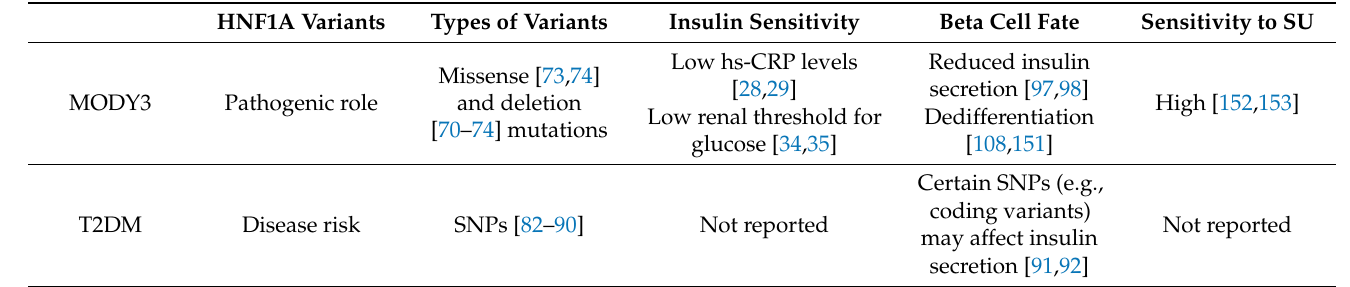
Table 1. Comparison of the roles of HNF1A variants in MODY3 and T2DM. hs-CRP, high-sensitivity CRP; SU,